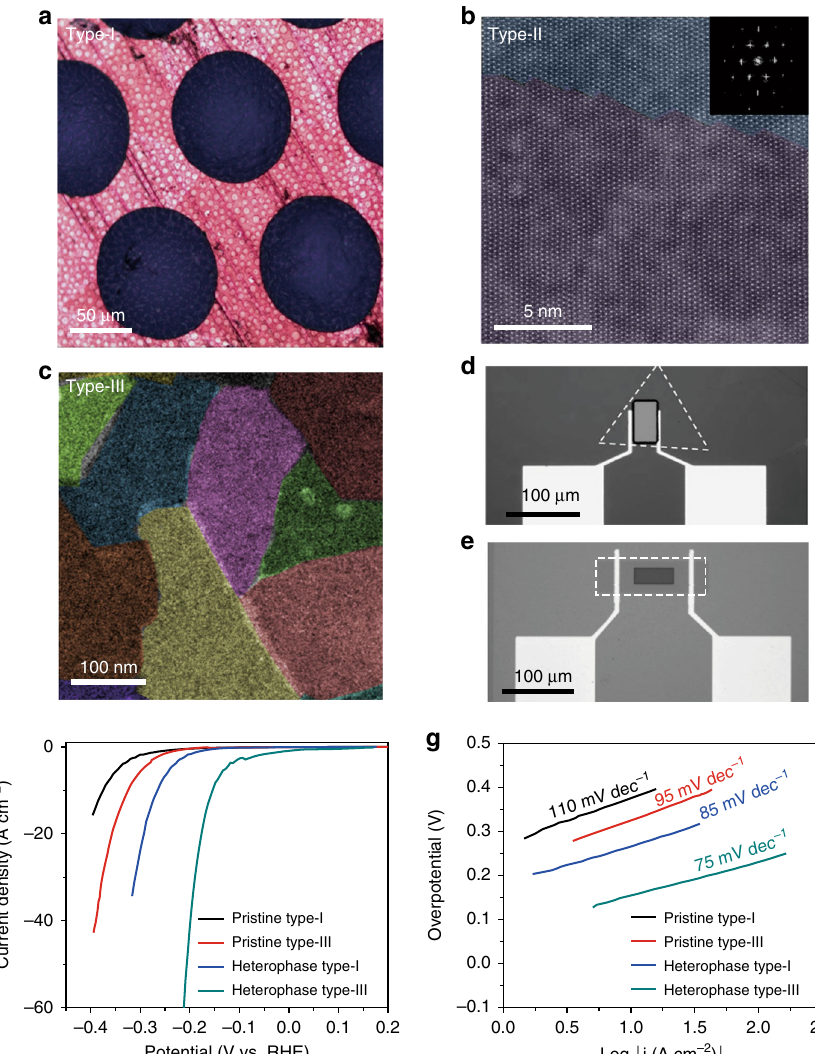
Fig. 1 Activity of 2H – 2H domain boundaries and 2H – 1T-phase boundaries for HER. a Optical image of the type-I MoS 2 with individual domain size of few hundreds microns transferred onto a TEM grid. b HRTEM images of as-grown type-II MoS 2 fi lm with highly orientated domains of few microns for the domain sizes. c False-color dark- fi eld TEM image of type-III MoS 2 with high-density 2H – 2H domain boundaries. d , e Optical microscope image of a individual MoS 2 single-crystal domain without 2H – 2H domain boundaries ( d ) and polycrystalline ML – MoS 2 with domain boundaries ( e ). Dashed regions indicate the HER window opened on the basal plane. f Polarization curves of the pristine type-I MoS 2 (without any domain boundaries), pristine type-III MoS 2 (with 2H – 2H domain boundaries), heterophase type-I MoS 2 (with 2H – 1T-phase domain boundaries), and heterophase type-III MoS 2 (with both 2H – 2H and 2H – 1T domain boundaries), respectively. g Tafel plots of the corresponding curves in